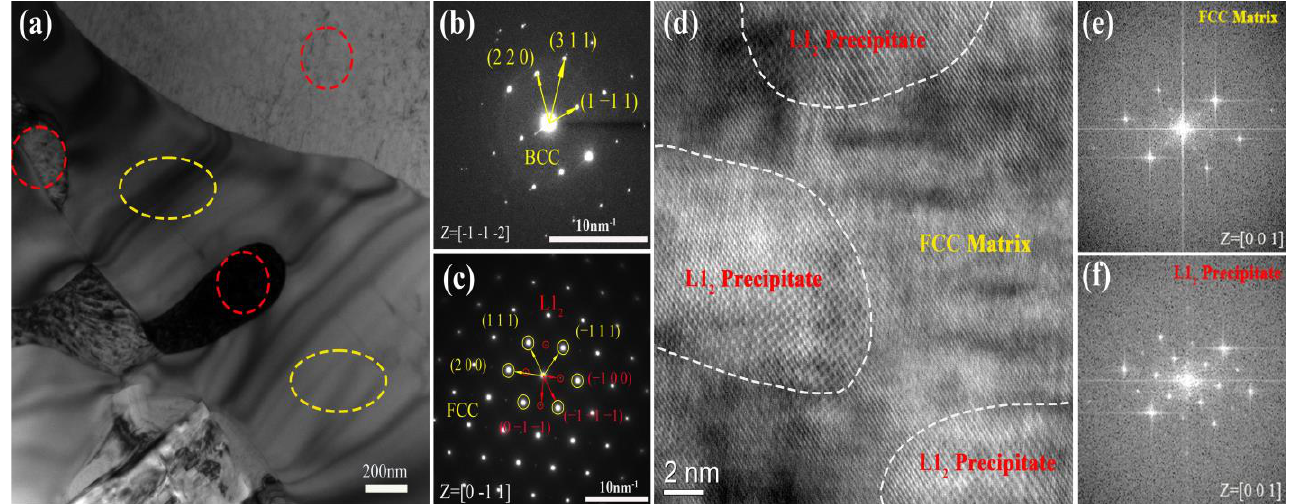
Figure 4. TEM images of the as-cast B0.5 HEA showing the complex microstructure morphology. ( a ) is the bright-field (BF) image of B0.5 HEA; ( b , c ) are the selected area electron diffraction (SAED) patterns of BCC and FCC phases, respectively. ( d ) is the high-resolution TEM (HRTEM) of the FCC matrix and L1 2 precipitate interface; ( e , f ) are the fast Fourier transform (FFT) images of the FCC matrix and L1 2 precipitate, respectively.